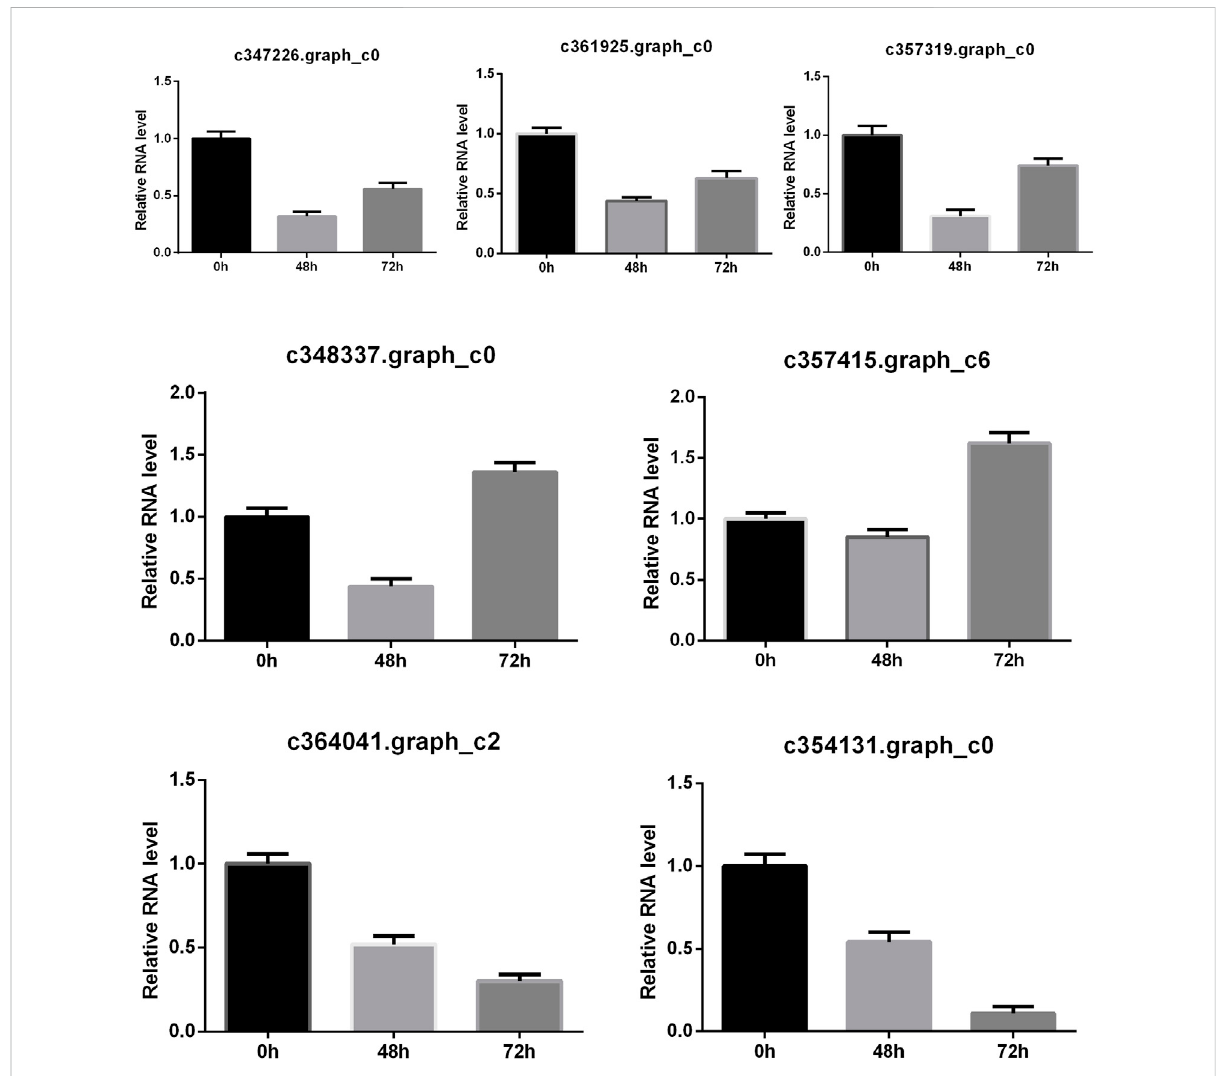
FIGURE 5 QRT-PCR veri fi cation of DEGs. The relative gene expression levels at different